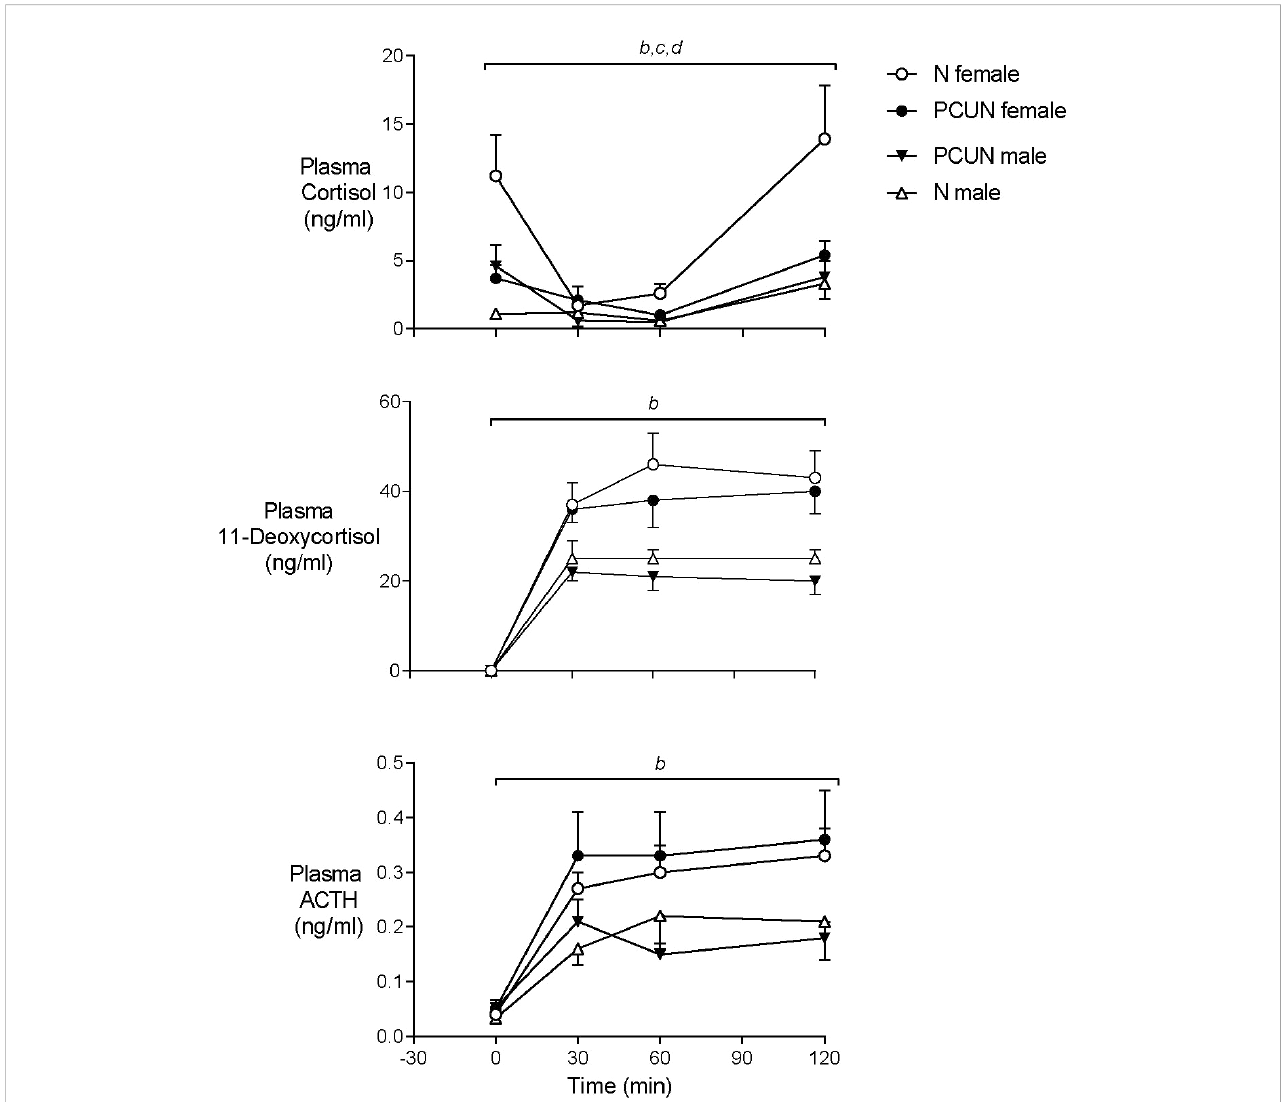
FIGURE 5 Adult plasma cortisol, 11-Deoxycortisol and ACTH responses to cortisol synthesis blockade with intravenous metyrapone (40 mg/kg) given at time ‘ 0 ’ . b sex effect ( p < 0.0001). c treatment x sex interaction ( p < 0.05). d treatment effect in females ( p < 0.05). Values are mean ±